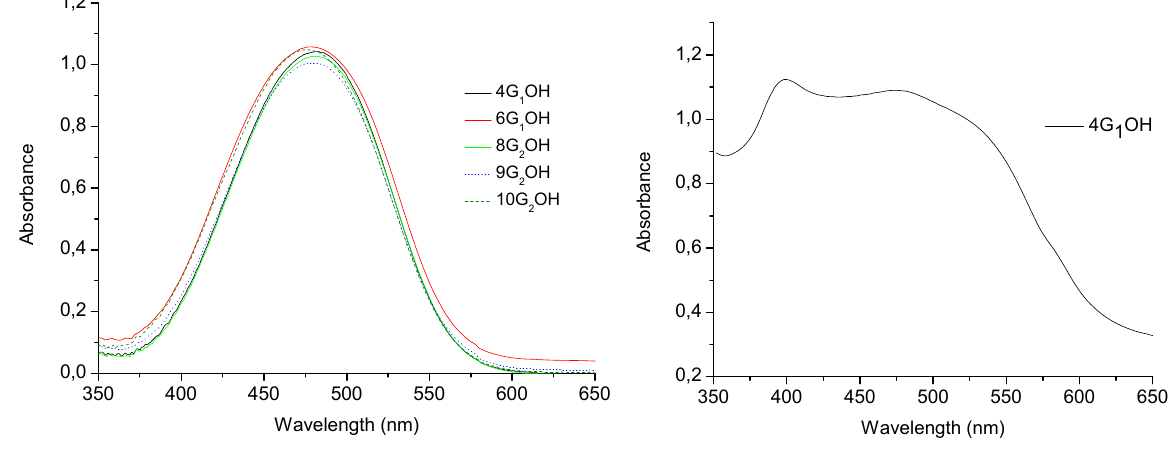
Figure 5. Absorption spectra of the obtained compounds: in solution ( left ) and in cast film ( right